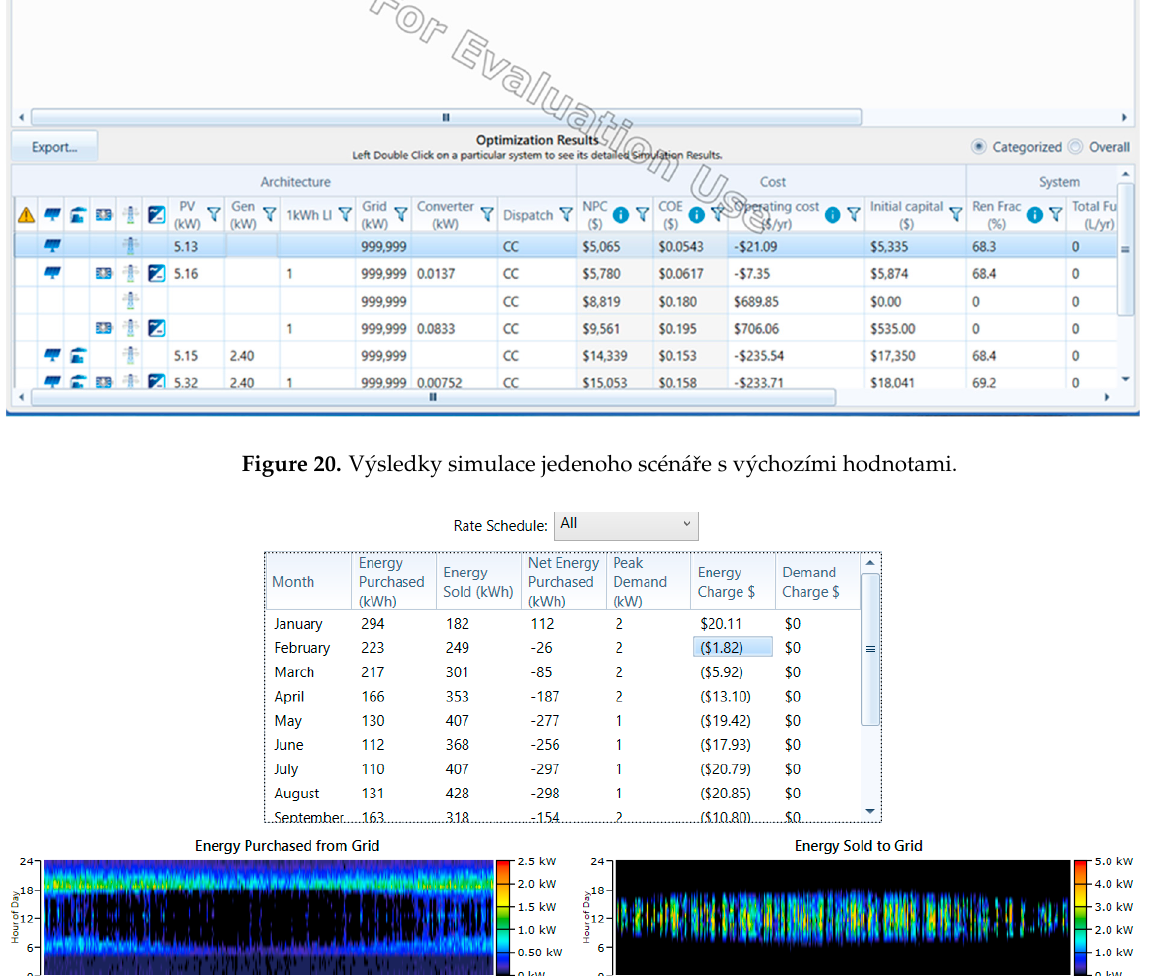
Figure 20. Výsledky simulace jedenoho scéná ř e s výchozími hodnotami.